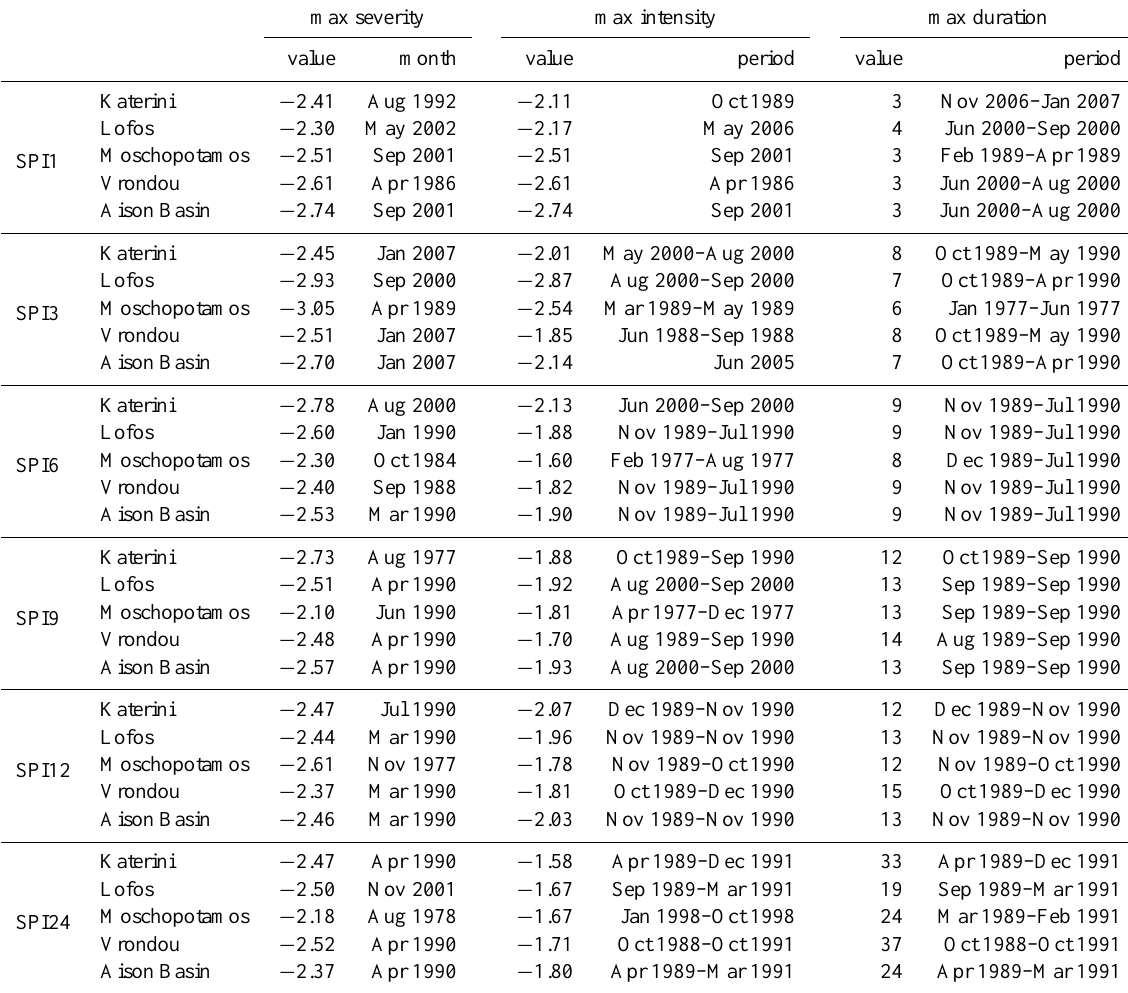
Table 8. Maximum values of drought characteristics for all stations and time